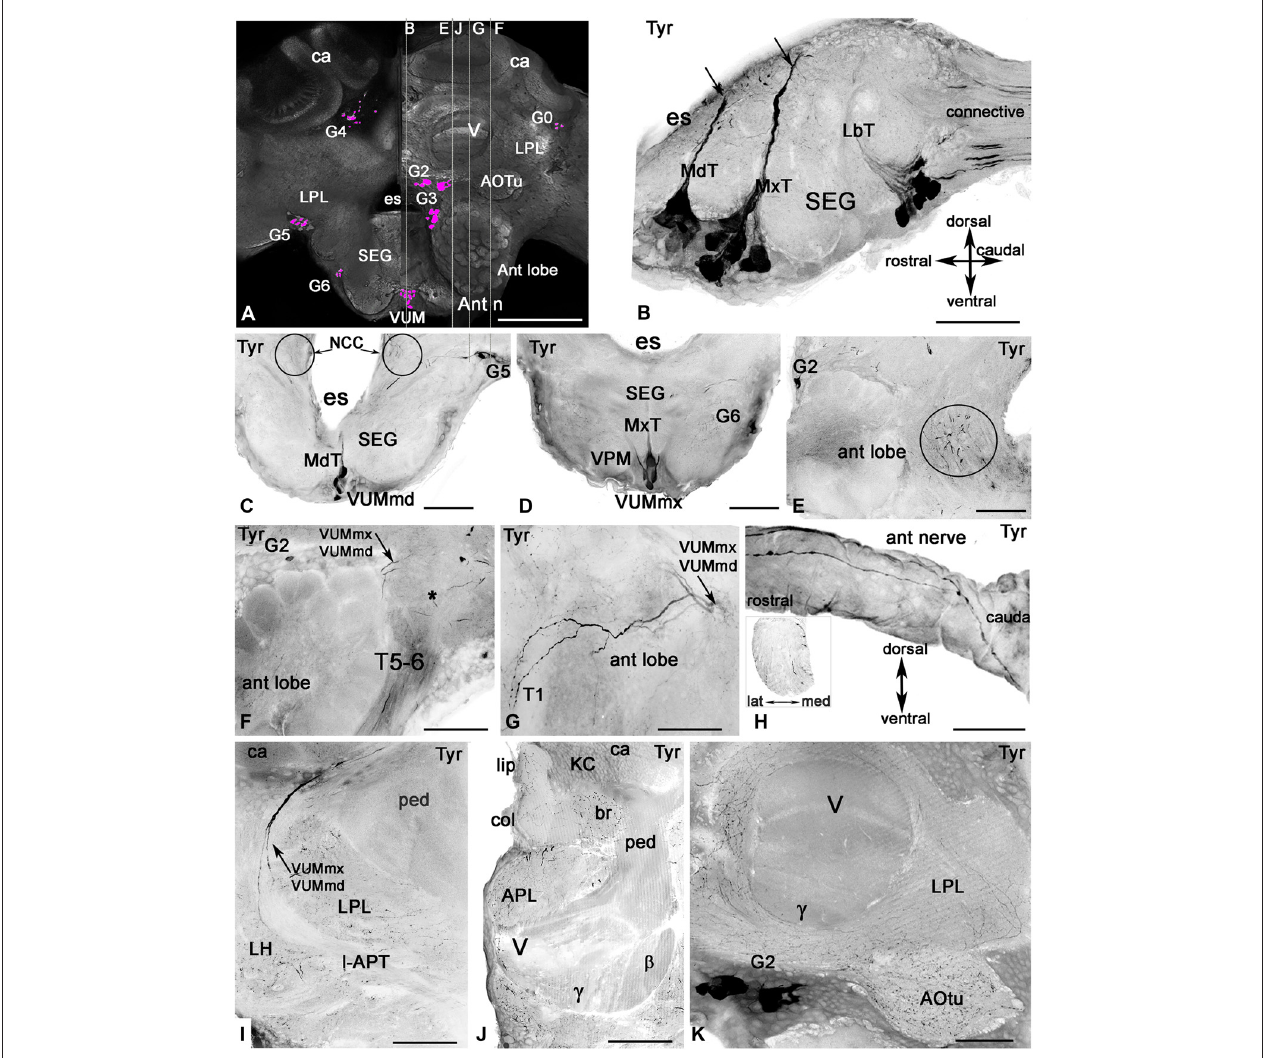
FIGURE 3 | Tyramine-like immunoreactivity in the honey bee brain using inverted fluorescence images. (A) Schematic representation of the brain (frontal view) with the groups of cell bodies labeled with anti-tyramine antibodies. The left and right halves of the schematic demonstrate the caudal and rostral planes of the brain. The tyramine containing cell groups (magenta) are G2-G6 and VUM. The plane of the sagittal sections on corresponding images (B,E,F,G,J) is indicated by the vertical lines. (B) The sagittal section through the SEG with anti-tyramine labeled groups of median neurons in mandibular (Md), maxillary (Mx) and labial (Lb) neuromeres with their primary neurites in corresponding Md (MdT), Mx (MxT) and Lb (LbT) tracts. (C,D) Frontal sections of SEG made via Md (C) and Mx (D) neuromeres respectively, show corresponding frontal view of VUMmd (C) and VUMmx (D) and ventral paired median (VPM) neurons. The VUM neurons send their primary neurites to the corresponding tracts, and the secondary neurites branch in the deutocerebrum (circle in C,E ). (F,G) Two tyramine immunoreactive axons from VUM neurons, one from MdN and one from MxN, innervate the antennal lobe (sagittal sections, front on the left) and give rise to ramifications in glomeruli and aglomerular neuropils of the antennal lobe (G) . Asterisk in (F) indicates dorsal lobe. (G) The tyramine immunoreactivity in tract T5-T6 is from unidentified neurons in the tritocerebrum and SEG. (H) These unidentified tyramine immunoreactive neurons enter into the antennal nerve and are running along the top of the antennal nerve in the sagittal view and inside of the nerve (frontal view, insert). (I) The secondary neurites from tyramine immunoreactive VUMmd and mx enter in the lateral antenna-protocerebral tract (l-APT) and innervate the lateral horn (LH) and mushroom body calyx (ca). (J) In the mushroom body calyx, they innervate the basal ring (br) and lip areas, which receive olfactory afferents from the antennal lobe. The mushroom body pedunculus (ped) and lobe are almost free from tyramine immunoreactive innervation (I,J,K) except for a few branches in the γ lobe (K) that might originate from LPM neurons from SEG. The arrow in (C) indicates tyramine immunoreactive fibers running alongside of the esophageal (es) to the corpora cardiaca nerve (NCC). Ant lobe, antennal lobe; ca, calyx of mushroom body; SEG, subesophageal ganglion; VUM, ventral unpaired median neurons; Ant n, antennal nerve; LPL, lateral protocerbral lobe; APL, anterior protocerebral lobe; AOTu, anterior optic tubercule; V, γ , β , vertical lobe of mushroom bodies, KC, Kenyon cell bodies. Scale bar: A = 250 µ m, B = 50 µ m, C–K = 100 µ